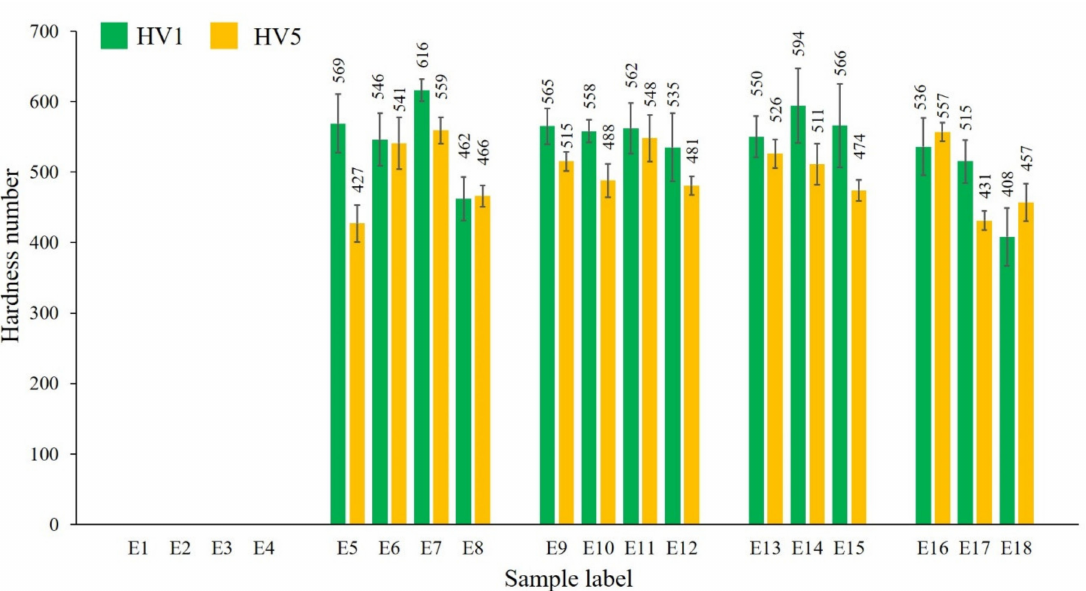
Figure 14. Hardness results of samples E1–E18, averaged for 10